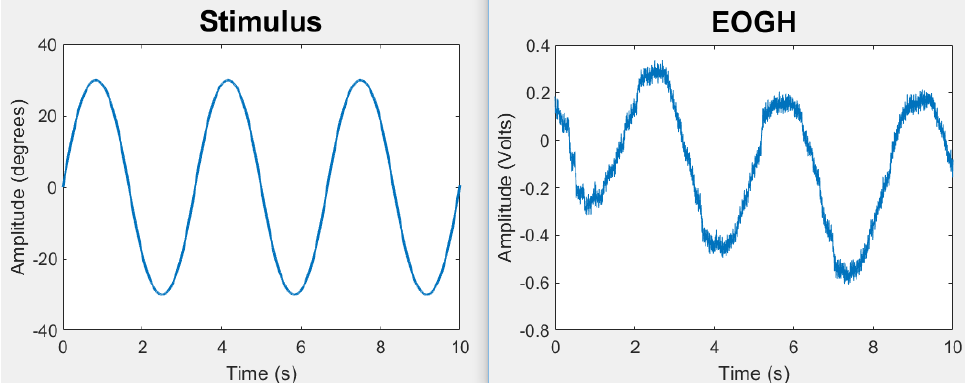
Figure 3. Example of a SPSS stimulus signal ( left ) and the EOG response acquired in the horizontal lead ( right